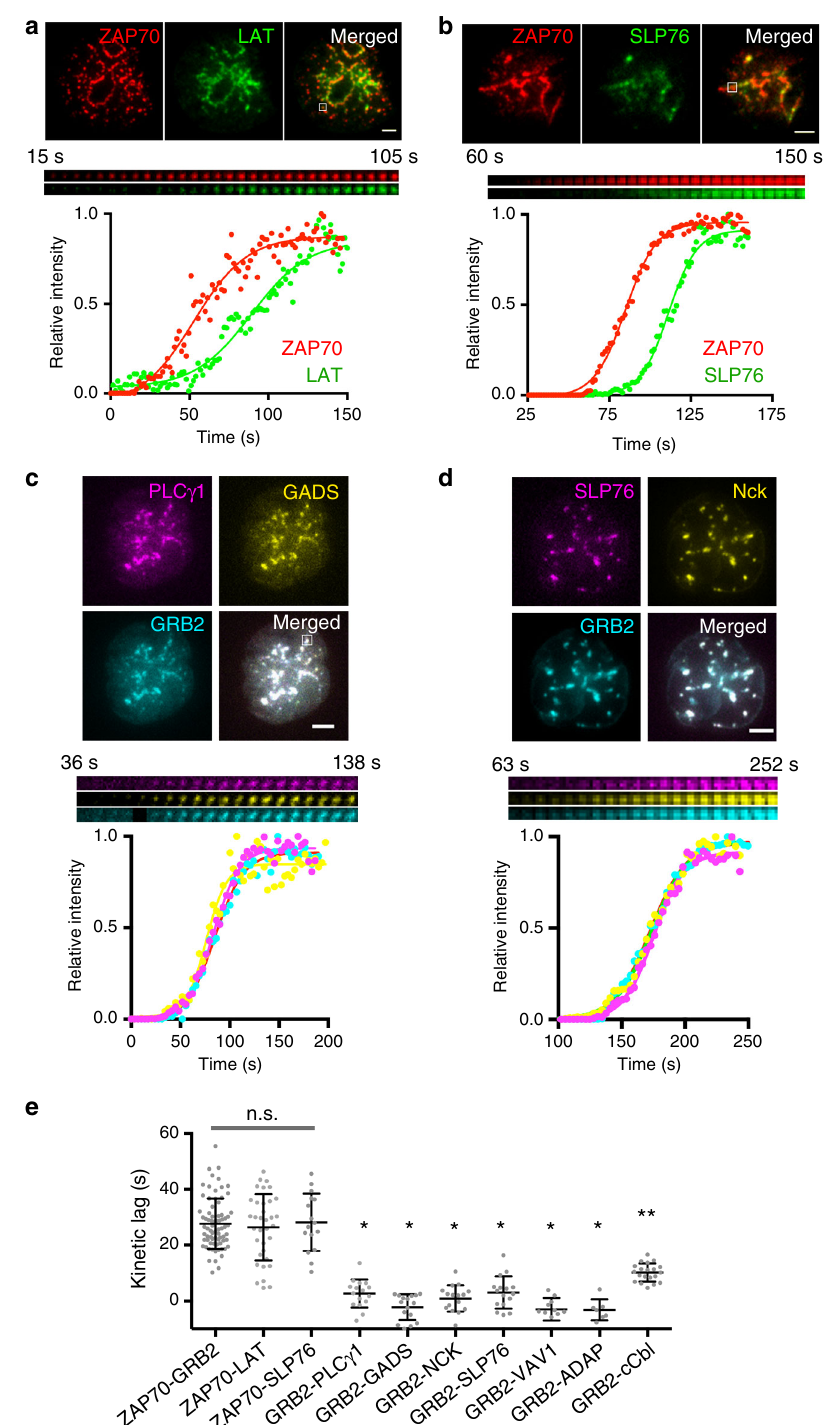
Fig. 3 Signaling cluster components are recruited simultaneously to microclusters. TIRF images of microclusters formed in Jurkat T cells activated on coverslip-bound anti-CD3 antibody at 21 o C were visualized using a LAT-Emerald (green) and ZAP70-Apple (red), b SLP76-Emerald (green) and ZAP70- Apple (red), c PLC γ 1-CFP (magenta), GADS-YFP (yellow), and GRB2-Apple (cyan), or d SLP76-CFP (magenta), NCK-YFP (yellow), and GRB2-Apple (cyan). a – d Time-lapse montage (middle) and relative intensity plot (bottom) of the boxed region in the top image shows simultaneous recruitment of signaling cluster components. The bottom graph shows a plot of the relative intensity per acquired time frame as a colored circle and the best- fi t sigmoidal curve as a colored line. Scales bars, 2 μ m. e Average kinetic lag observed between the recruitment of indicated pair of microcluster components at 21 °C. n.s., not signi fi cant. * p < 0.0001 compared to ZAP70-GRB2. ** p < 0.0001 compared to kinetic lags from GRB2-PLC γ 1 to